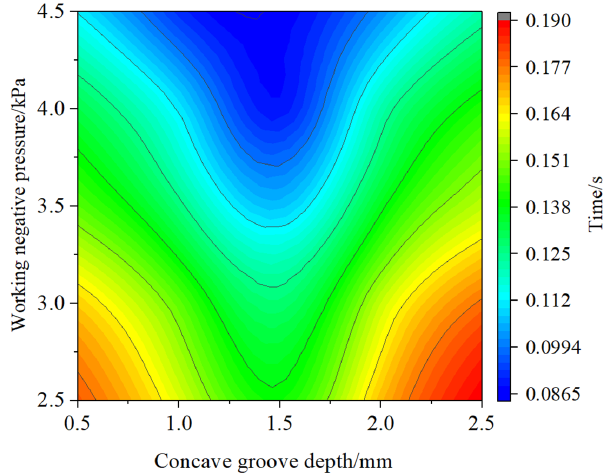
Figure 17. Influence of two-factor interaction on the seed picking-up time.